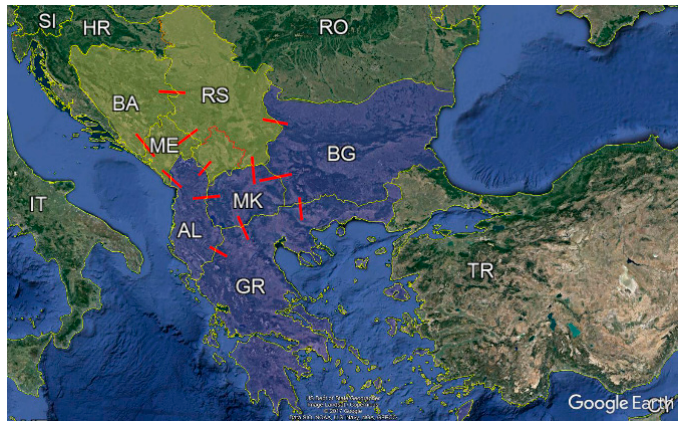
Figure 2. Southeast Europe region with electricity interconnections. Table 1. Transmission capacities on Southeast Europe interconnections (in MW), year 2020.